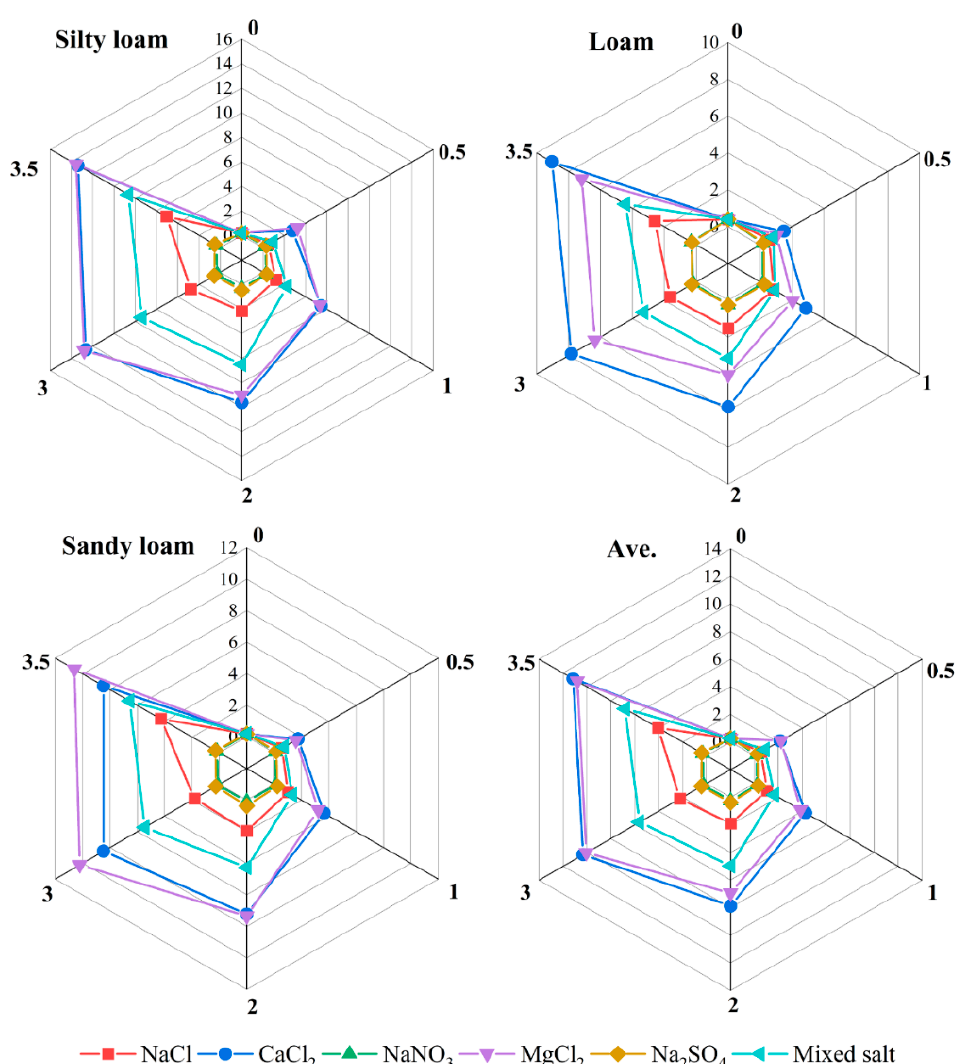
Figure 2. Effects of different salt types and salt concentrations (0, 0.5%, 1.0%, 2%, 3%, and 3.5%) on the Cd desorption rates (%).